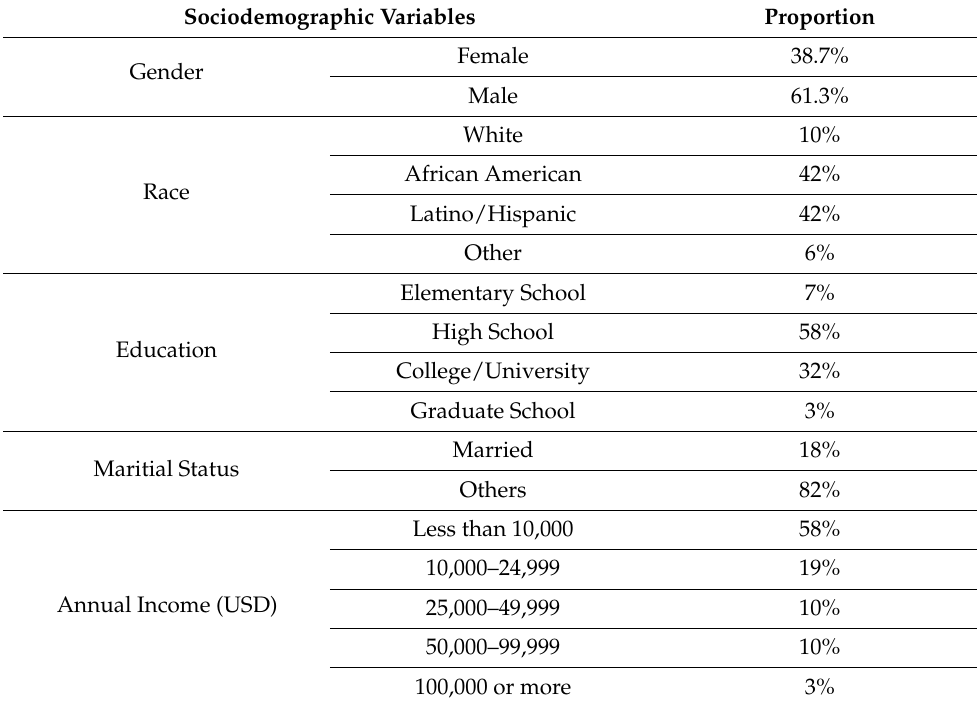
Table 3. Descriptive statistics of the Chicago participants’ sociodemographic characteristics. Sociodemographic